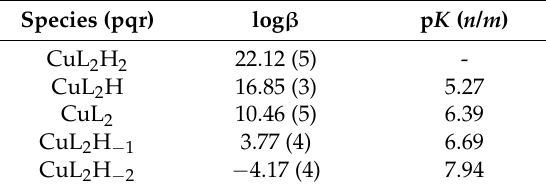
Table 3. Stability constants log β (pqr) and p K values of the complex species formed by Cu(II) with Ac-SLHHLG-NH 2 at 1:2 metal-to-ligand molar ratio. (T = 298 K; I = 0.1 M KNO 3